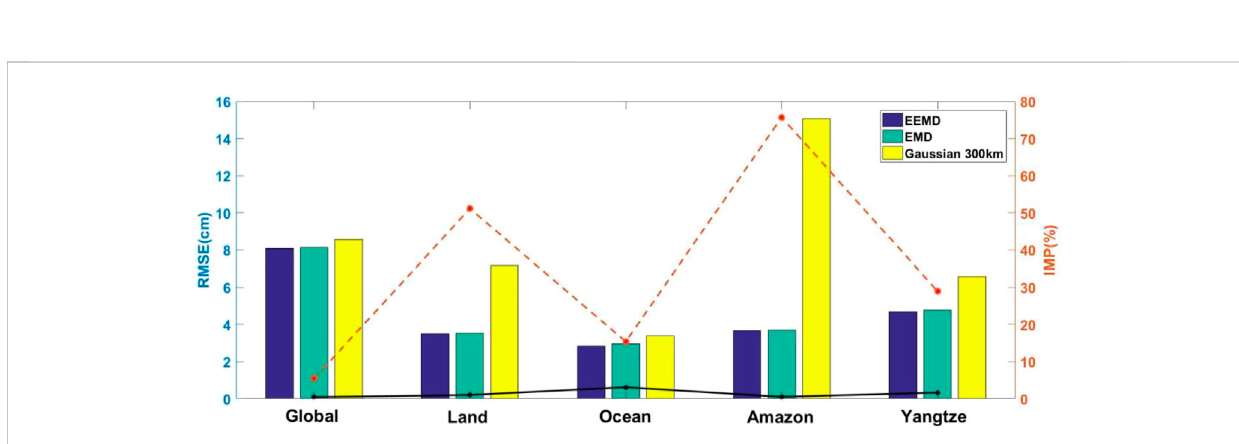
FIGURE 11 The spatial mean RMSEs of EEMD, EMD and Gaussian 300 km for all available months over April 2002 to August 2016 in fi ve selected global and regional areas and the corresponding IMPs (red dotted line: EEMD is relative to Gaussian; black line: EEMD is relative to EMD).